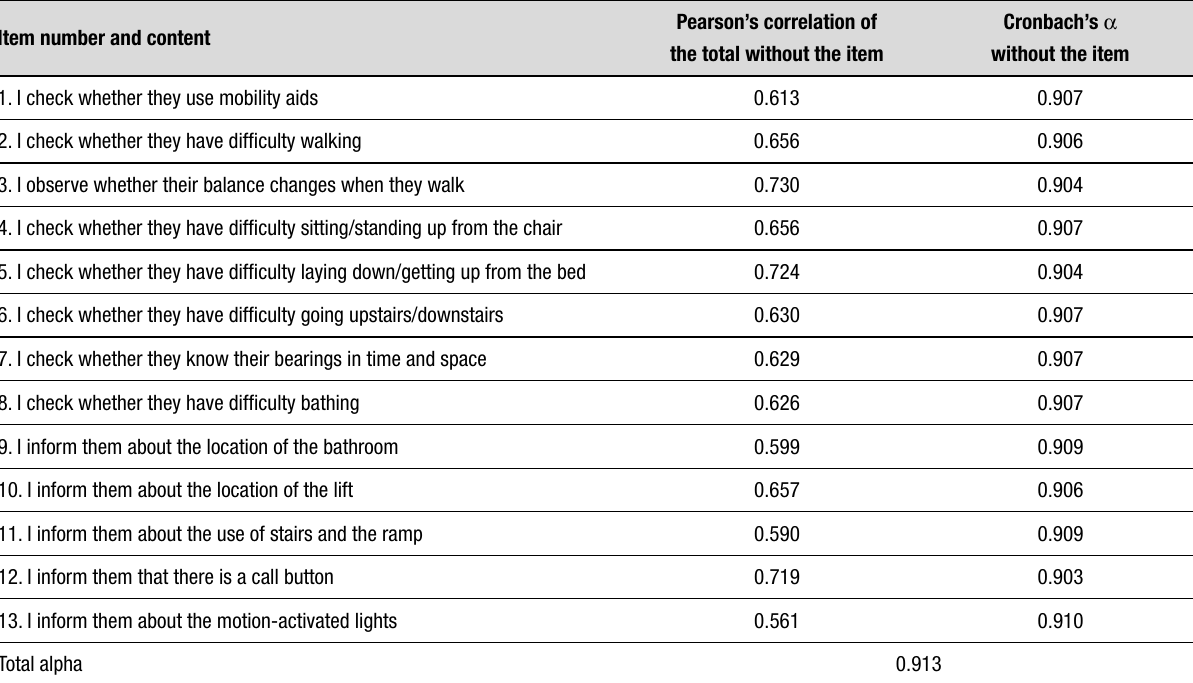
Table 1. Pearson’s correlation of the items that make up the Scale for Practices of Identification of and Information on Fall Risk Factors in the Admission of Older Adults and Cronbach’s alpha of items with their total, without the item. Lisbon, Portugal.